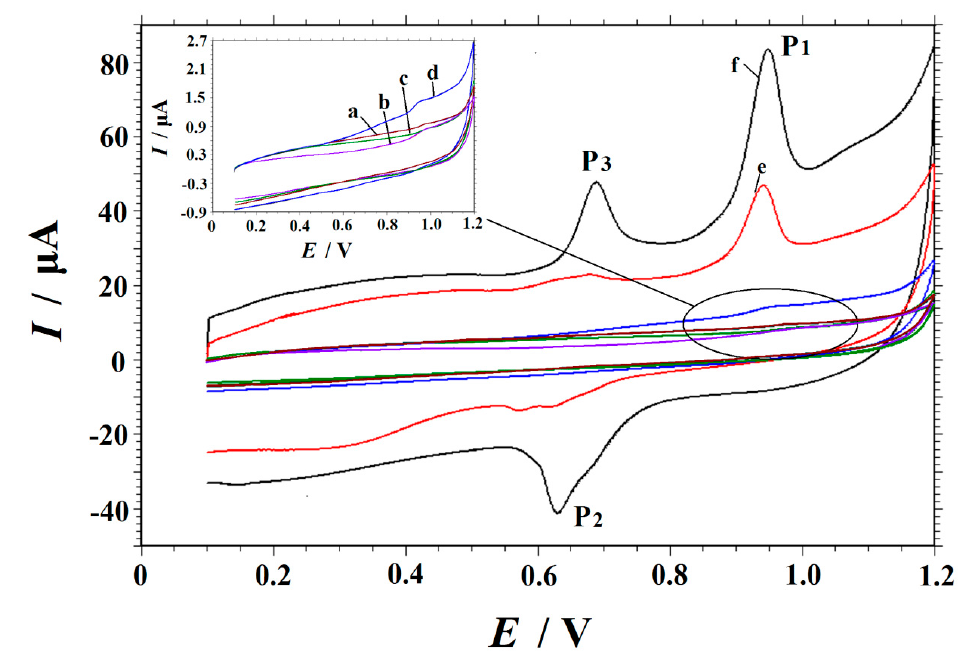
Figure 4. CVs obtained on different electrodes in 0.1 M HCl solution containing 10 µM vanillin (a: bare GCE; b: GO/GCE; c: CeO 2 /GCE; d: CeO 2 /GO/GCE; e: ERGO/GCE; f: CeO 2 /ERGO/GCE). Scan rate: 0.1 V·s − 1 . Table 1. Detailed data of CVs of 10 µM vanillin recorded at different electrodes.